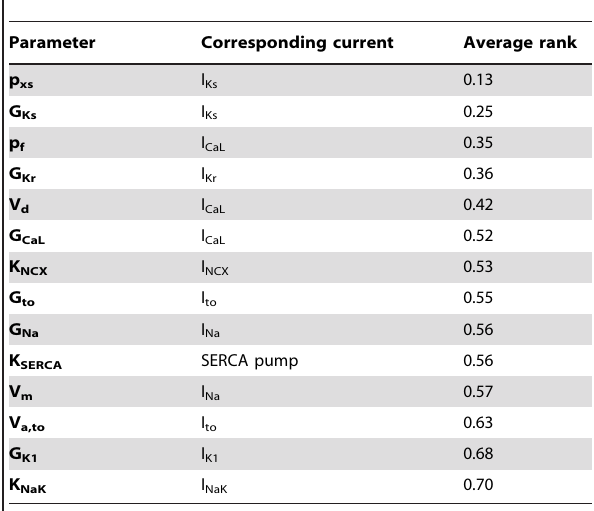
caused a small increase in I Ks , but the magnitude of the increase Table 2. Parameter rate dependence consensus list.